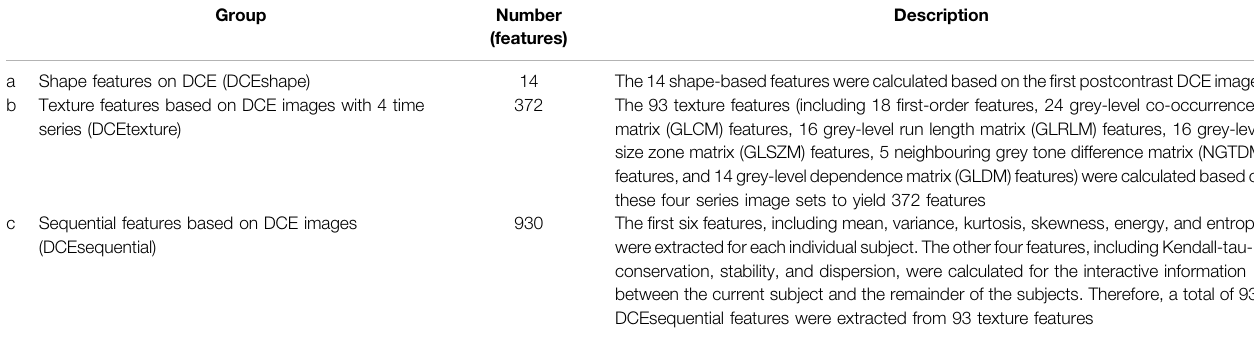
TABLE 1 | Three groups of extracted